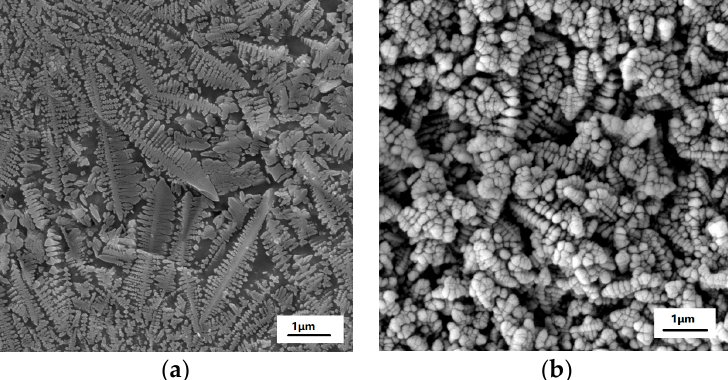
Figure 2. SEM images of MAS in etching conditions of ( a ) 5 mol/L HF for 10 s and ( b ) 20 mol/L HF for 30 min.